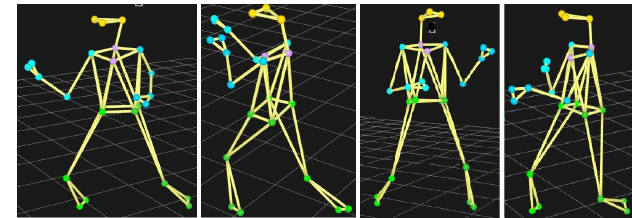
Fig. 2. Examples of postures from kata Bassai Dai (MoCap